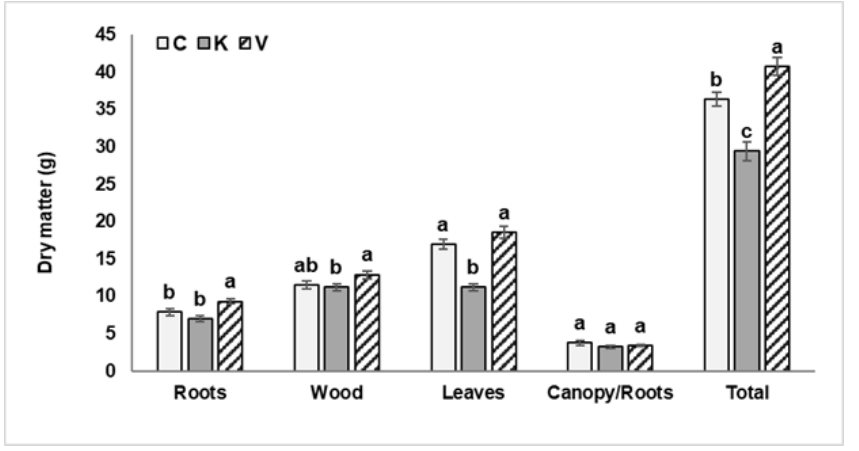
Figure 4. Effect of kaolin (K) and 1-p-menthene (V) on dry matter of roots, wood, leaves, canopy/roots ratio and total dry matter at the end of growing season. C: control. Vertical bars indicate ± SE (standard error) of the means. Different letters indicate significant differences according to Duncan’s multiple-range test ( p = 0.05).